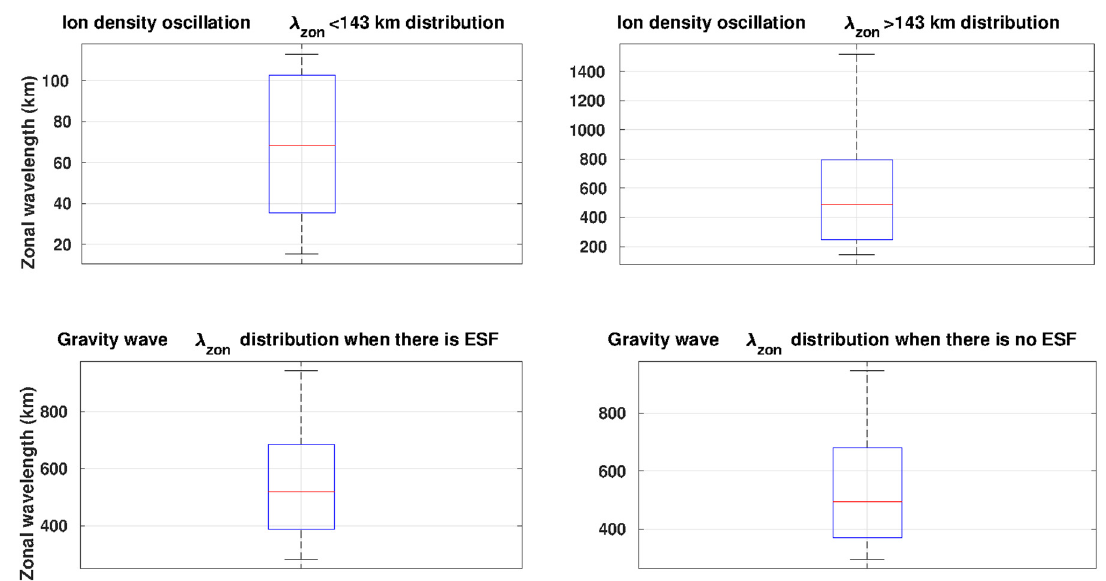
Figure 14. Box–and-whisker of zonal wavelengths of ion density perturbation for the cases less than ( top left ) and greater than ( top right ) 143 km wavelengths and atmospheric gravity waves for the cases of irregular ( bottom left ) and non-irregular ( bottom right ) ionosphere.